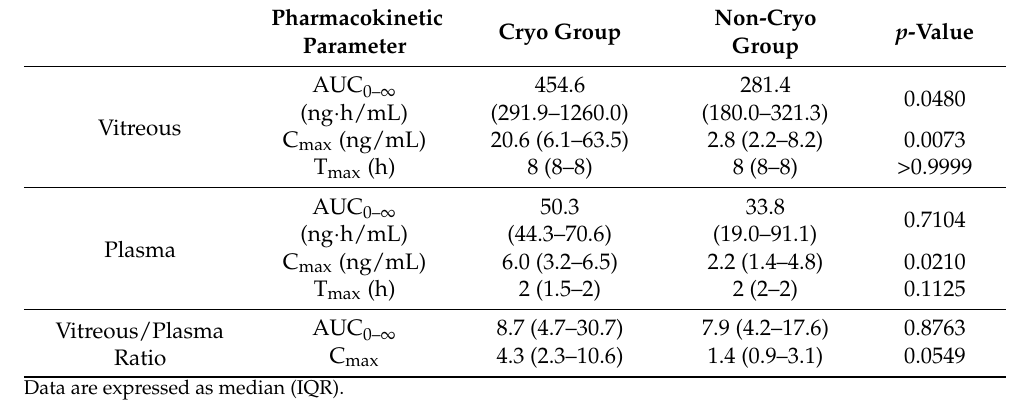
Table 3. TPT pharmacokinetic parameters calculated from vitreous and plasma compartment in the cryo and non-cryo groups.